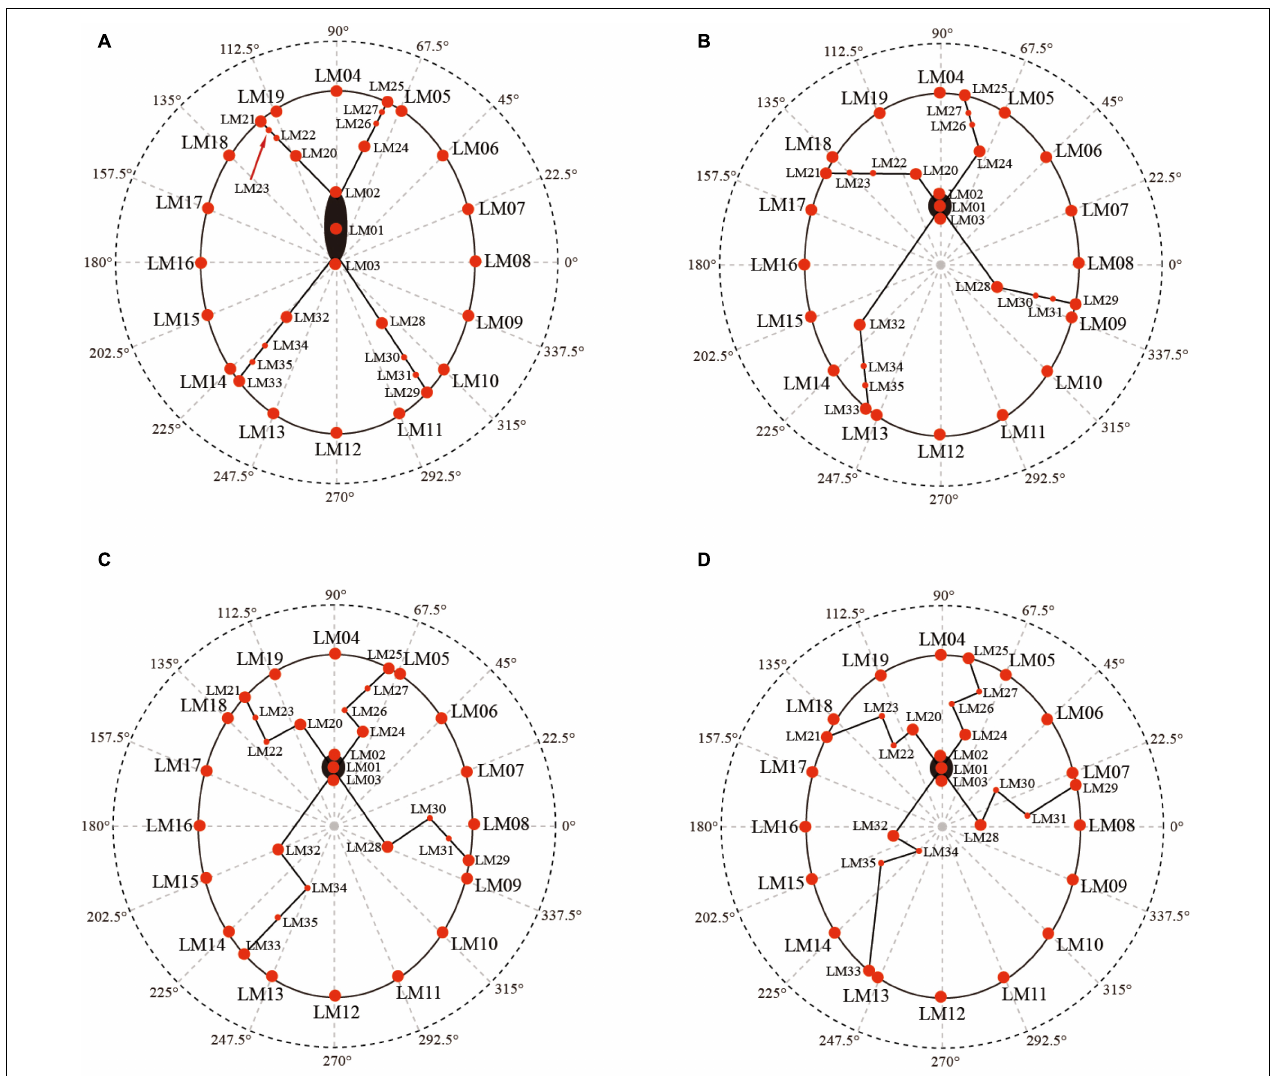
FIGURE 2 | Definition of the 35 landmarks on starch granule. (A) Extinction cross with no bend; (B) each arm with one bend; (C) each arm with two bends; and (D) , each arm with three